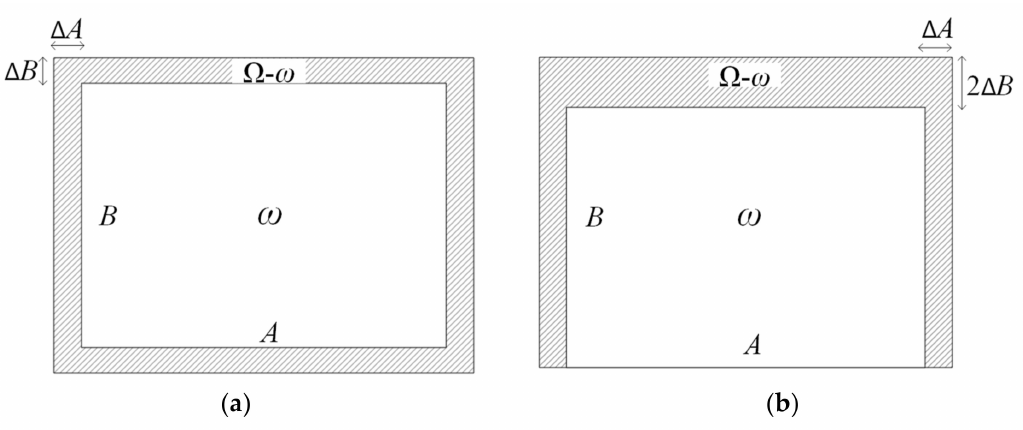
Figure 8. Mode of soil convergence: ( a ) uniform convergence; ( b ) nonuniform